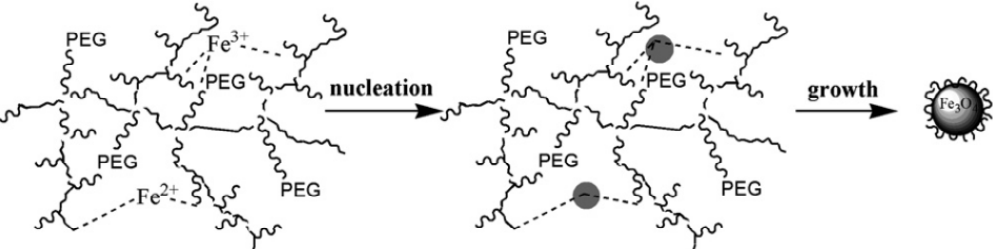
Figure 23. Synthesis of Fe O /polymer nano-composite in the presence of PPEGMEA- g - 3 4 PMAA densely grafted double hydrophilic copolymer. PPEGMEA: poly(ethylene glycol) methylether acrylate. Reprinted with permission from [3]. Copyright 2008 Royal Society of